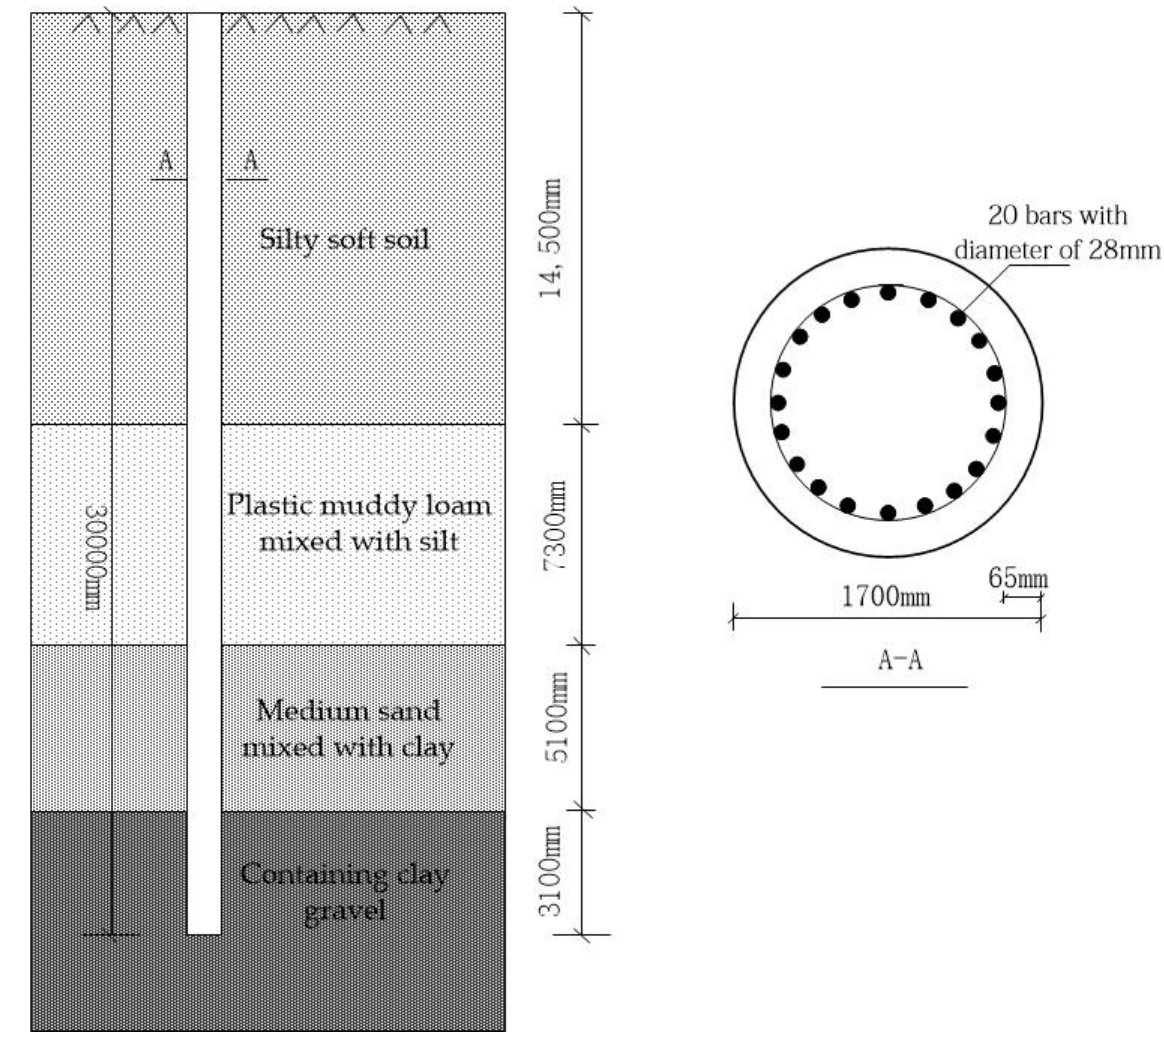
Figure 5. Site pile simplification and reinforcement. Table 1. Physical and mechanical properties of foundation soil. Table 1. Physical and mechanical properties of foundation